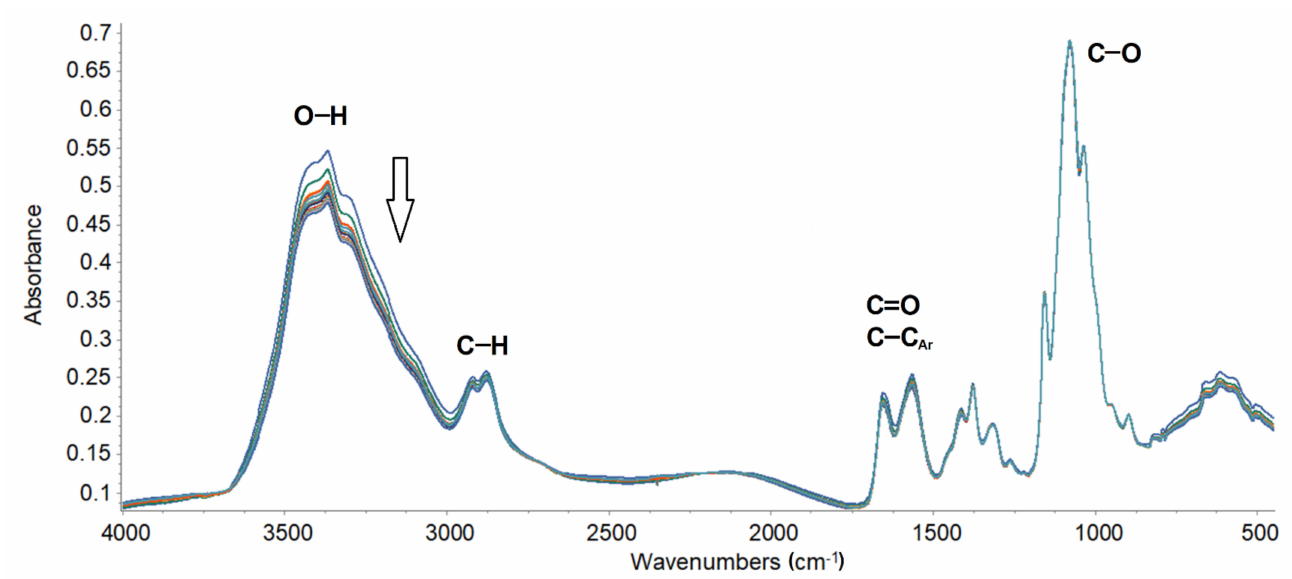
Figure 10. Changes in FTIR spectra of the CS film + 5% DMASQ during 6h UV irradiation (the most important bands have been assigned to appropriate groups; the arrow shows the direction of